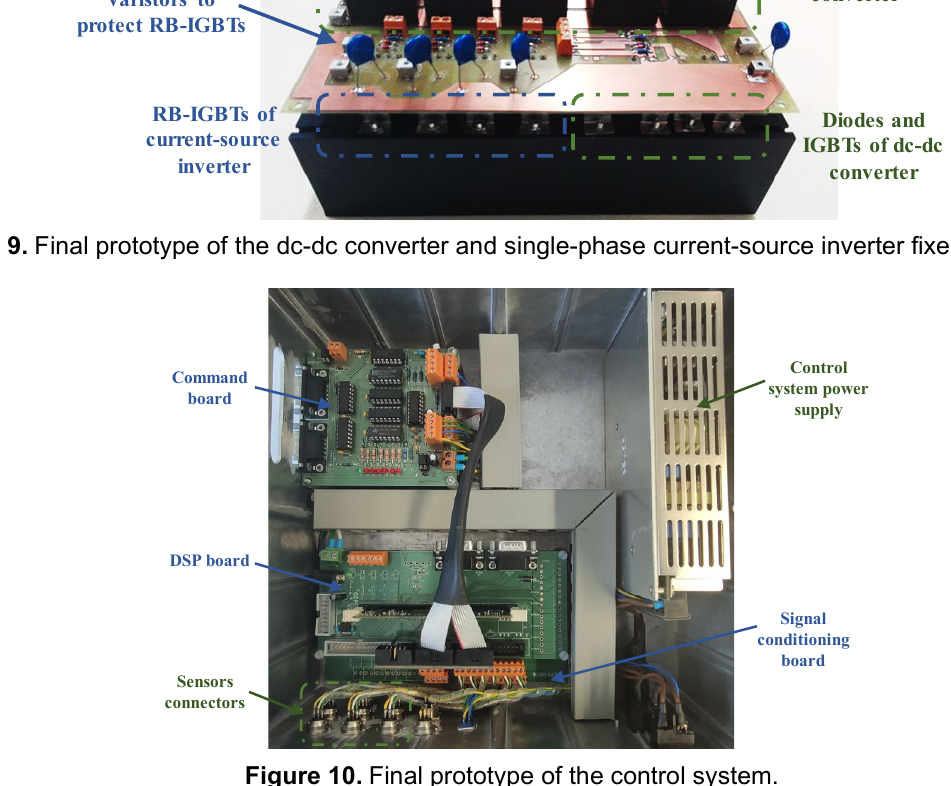
Figure 10. Final prototype of the control